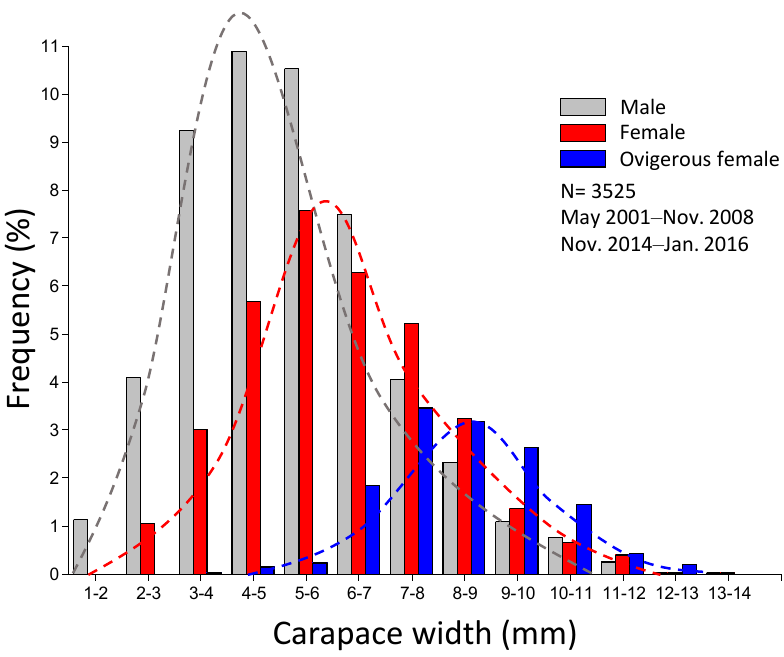
Figure 5. Overall size-frequency distribution of D. japonicus during the sampling periods.